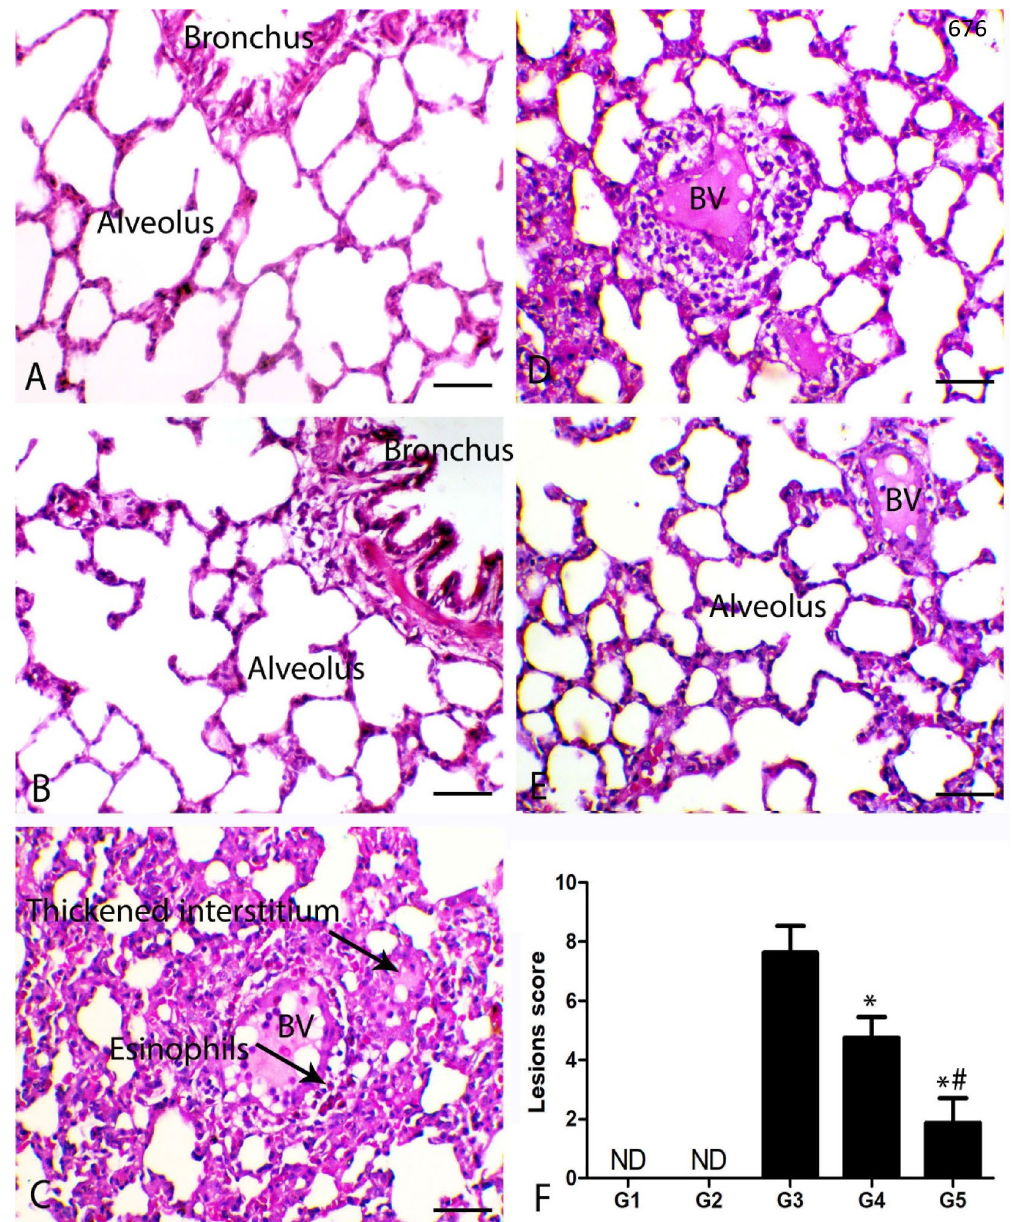
Figure 2. Photomicrograph of the pulmonary sections of the different groups. (A) The lung of G1 and (B) lung of G2 showing normal alveoli and bronchi. (C) Lung of G3 showing interstitial pneumonia associated with perivascular inflammatory cells infiltration mostly eosinophils, BV indicates blood vessels revealing damage of its wall. (D) Lung of G4 showing decrease both pneumonia and perivascular inflammatory cells infiltration. (E) Lung of G5 showing thin alveolar septa and with marked increase the alveolar spaces. H&E stain bar = 50 µm. (F) Quantitative lesion score showing marked decrease the pulmonary lesions, * indicates significe in comparing with G3 (P < 0.005) and # indicates significance in comparing with G4 (P <